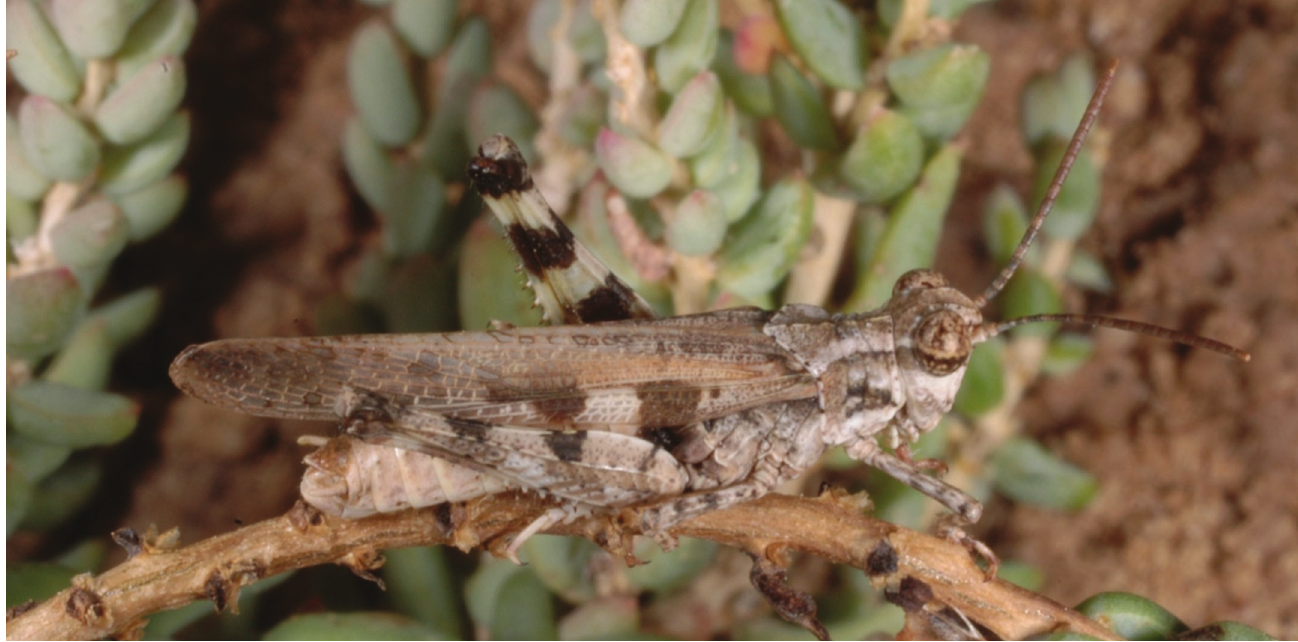
Fig. 3. Male Mioscirtus wagneri on alkali seepweed host plant, Suaeda vera. Photo by P.J.